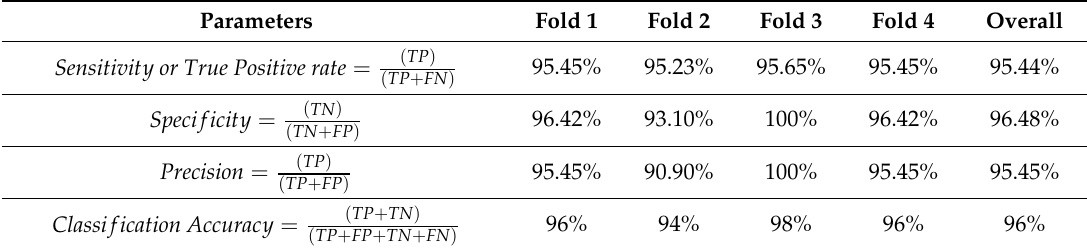
Table 16. Calculated performance parameters for fuzzy inference system.